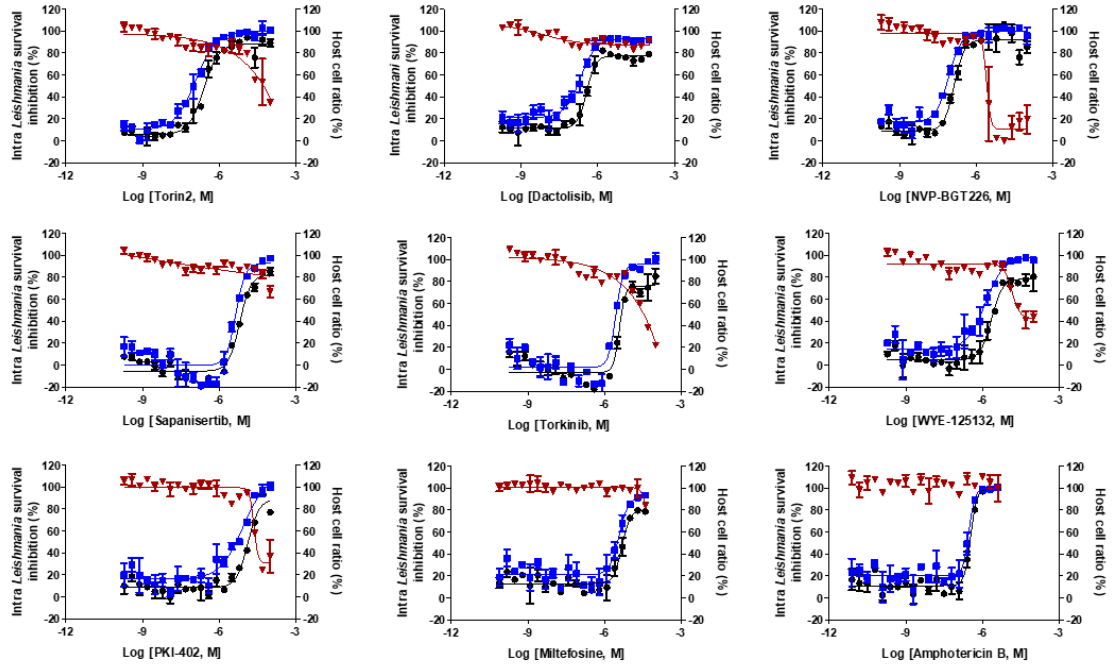
Figure 3. Dose-response curves of miltefosine, amphotericin B, and mTOR/PI3K compounds against Table 1 cells infected with intracellular L. donovani . Inhibition infection ratio (%) ( ● black-filled circles); inhibition parasite number (%) ( ■ blue-filled squares); and host cell ratio (%) ( ▼ red-filled triangles). The results are expressed as mean ± standard deviation values for duplicate experiments.